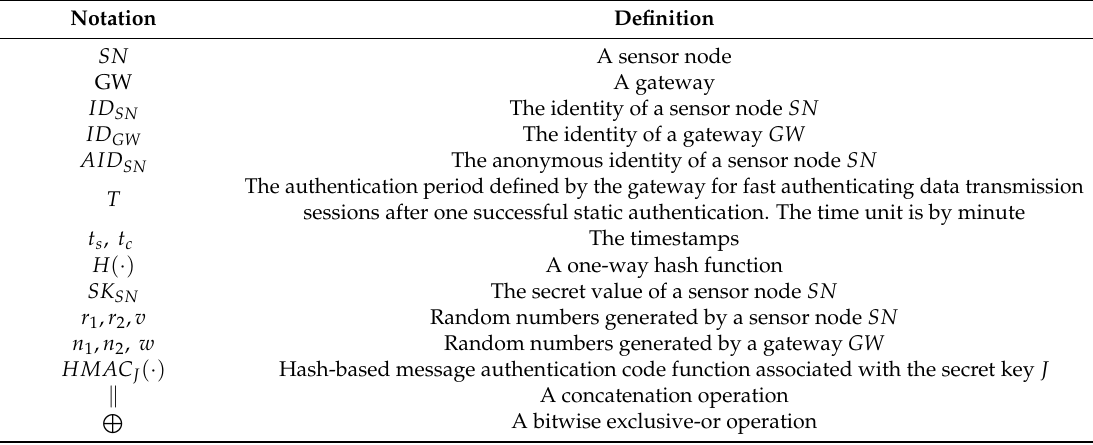
Table 1. The notations and their